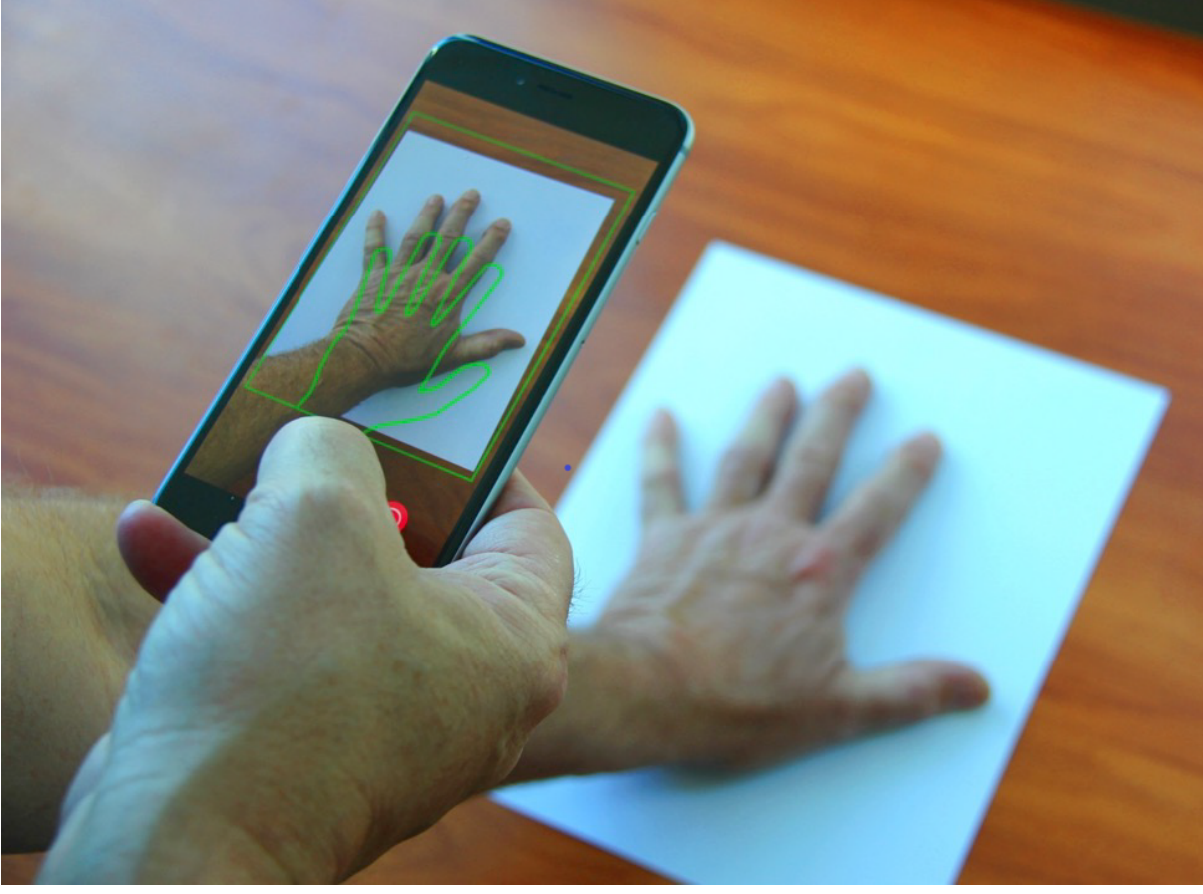
Figure 4. Hand optical imaging using letter size paper for